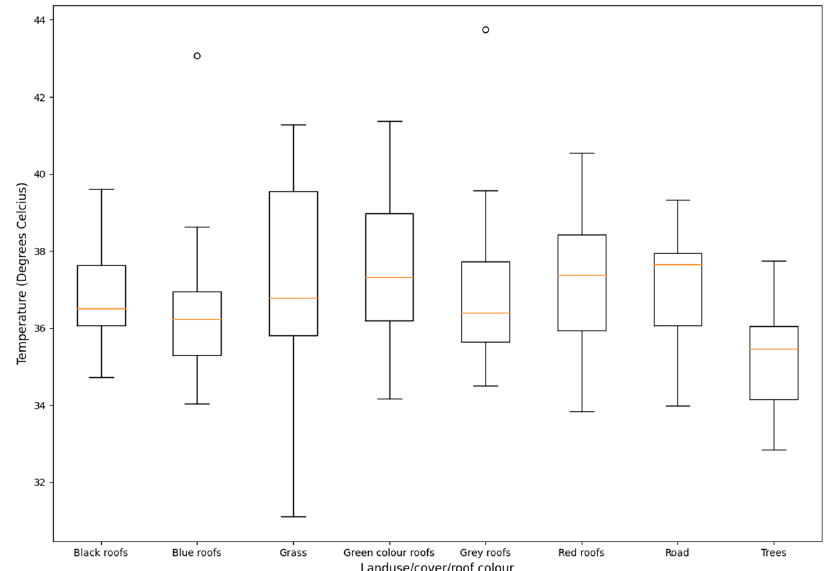
Figure 5. Observed variations of LST with LULC and roof colour classes in the study area.